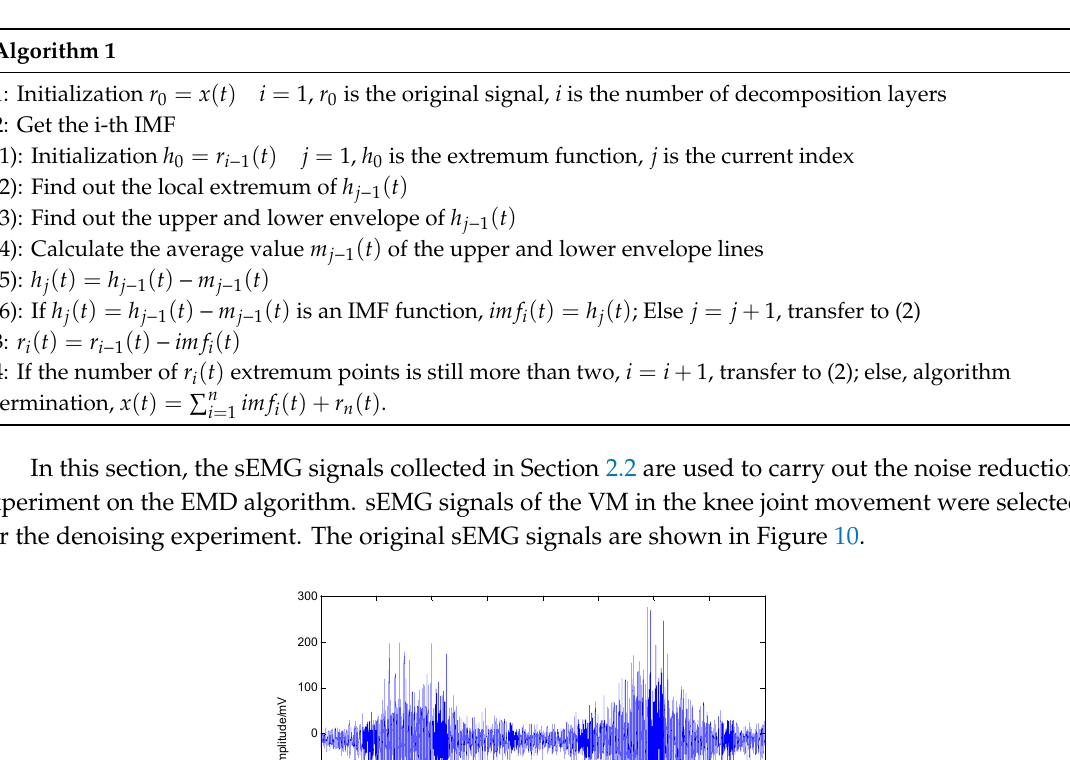
Table 2. Six experimental situations and abbreviations.